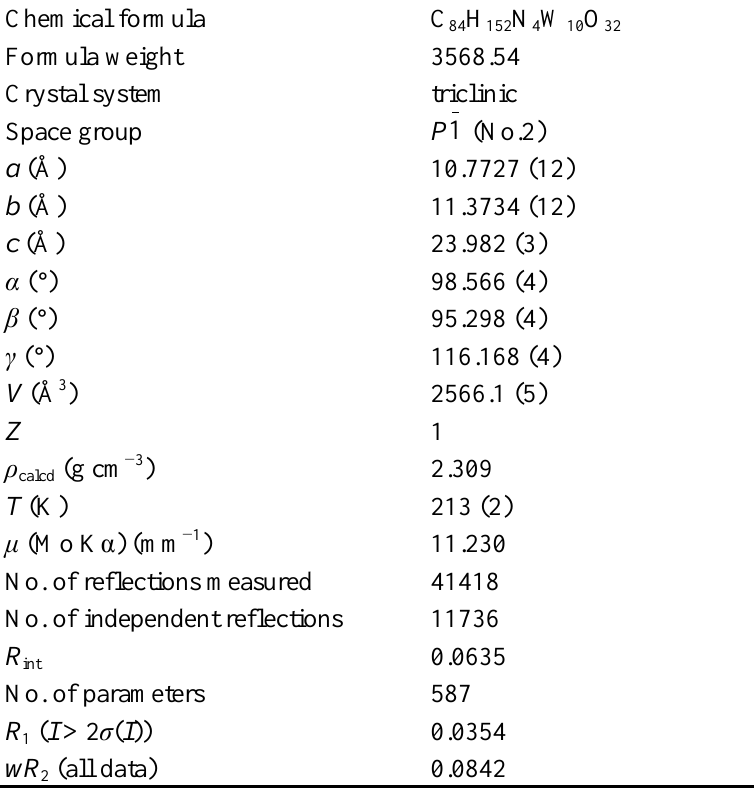
py-W . ( a ) Packing diagram along b axis (W 16 10 anion. Displacement ellipsoids are drawn 10